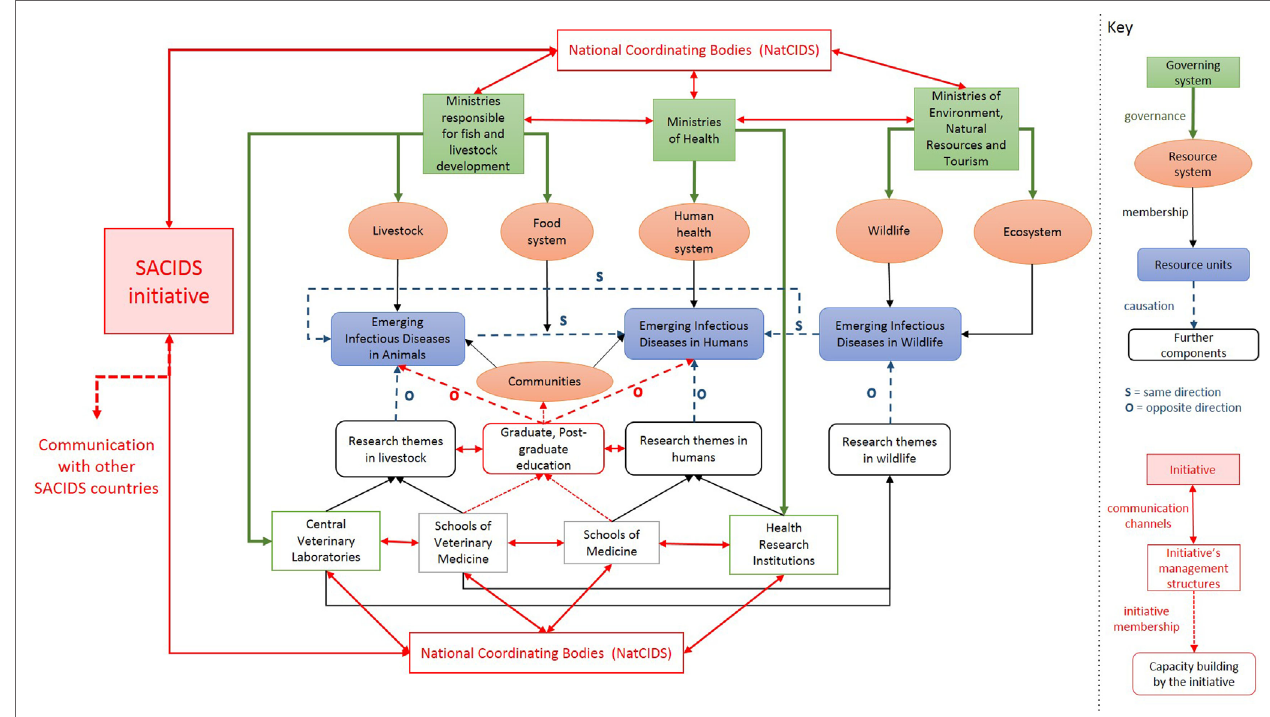
FigUre 2 | The Southern African Centre for Infectious Disease Surveillance (SACIDS)’ program placed in the context within which it